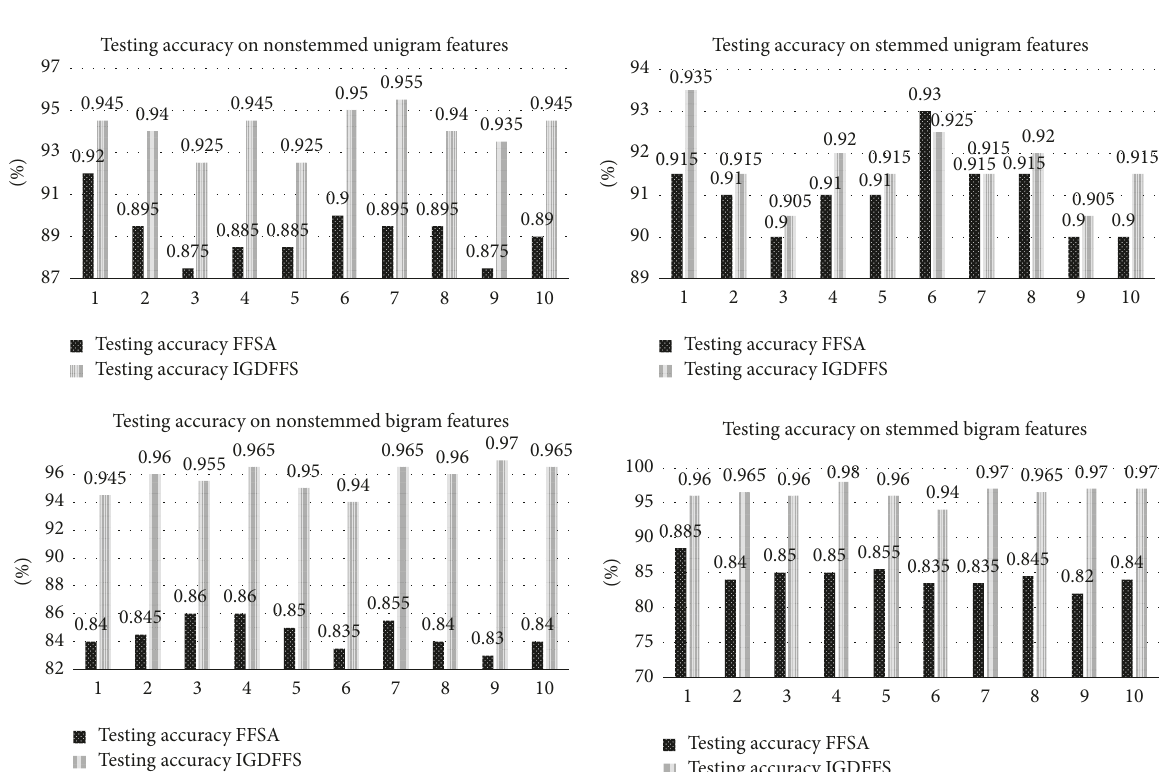
Figure 2: Feature selection performance